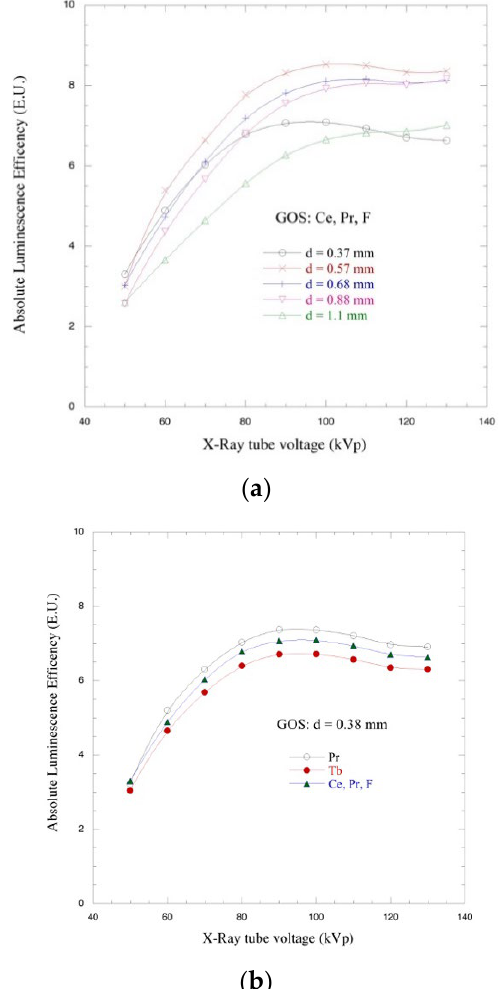
Figure 7. ( a ) Absolute luminescence efficiency (ALE) of Gd 2 O 2 S:Pr,Ce,F powder screens with different thicknesses and same dopant agents. ( b ) ALE of Gd 2 O 2 S powder screens with different dopants and same thickness. The vertical axis units are E.U. values (1 E.U equal to µW m −2 / mR s −1 ). The solid lines in the graphs are guides for the eyes.